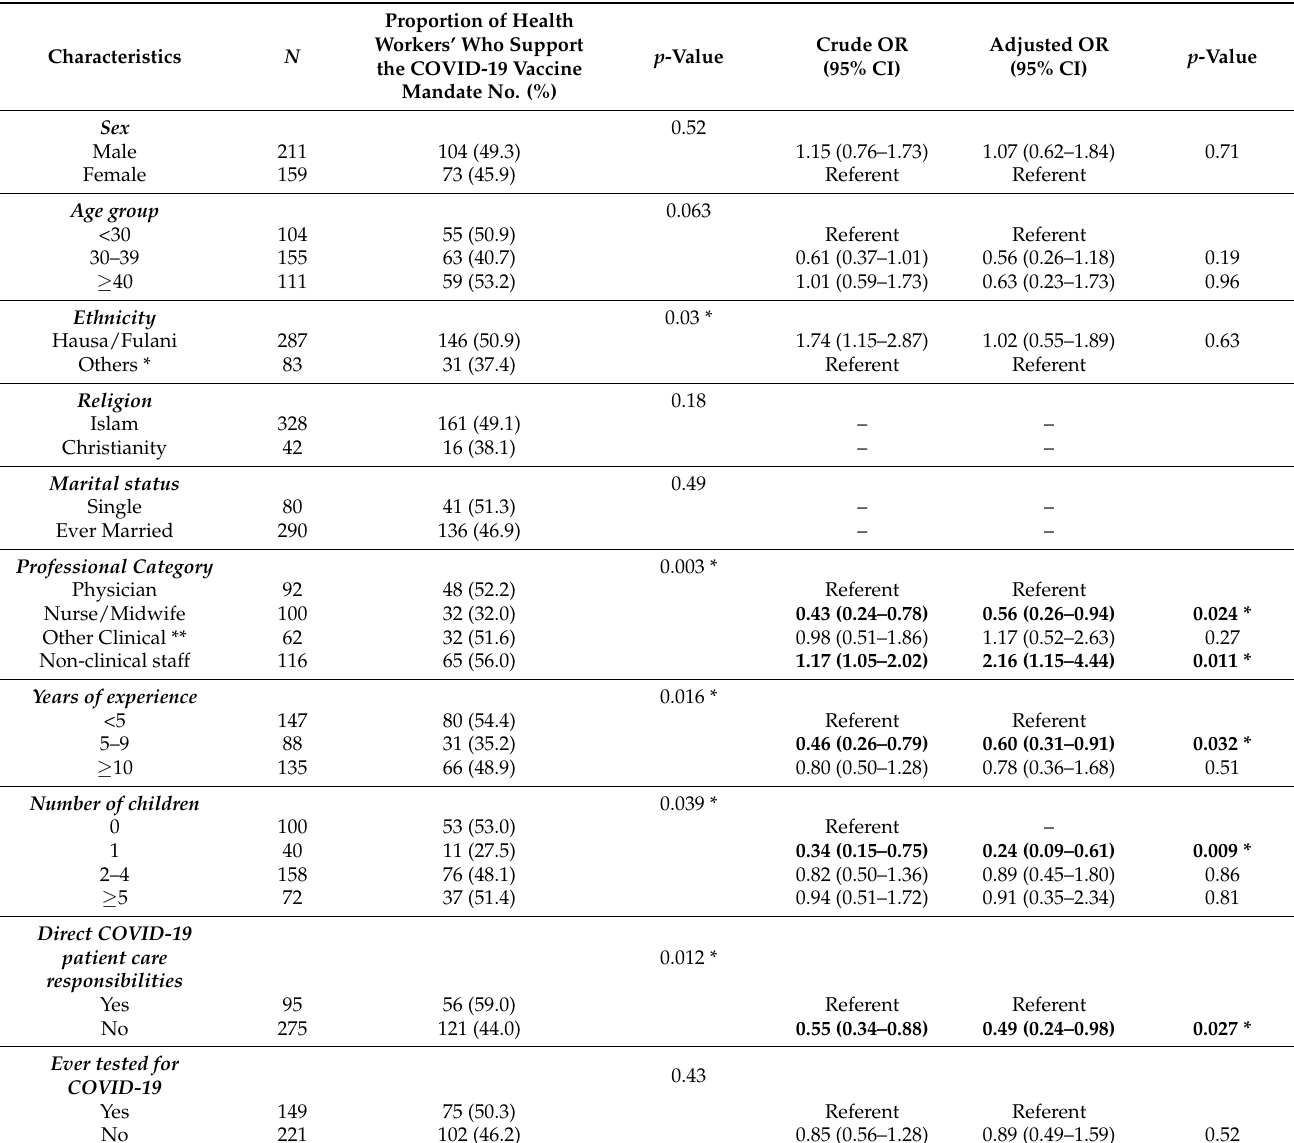
Table 3. Logistic regression model for predictors of health care workers’ support for COVID-19 vaccination-or-testing mandate, Kano, Nigeria ( N =